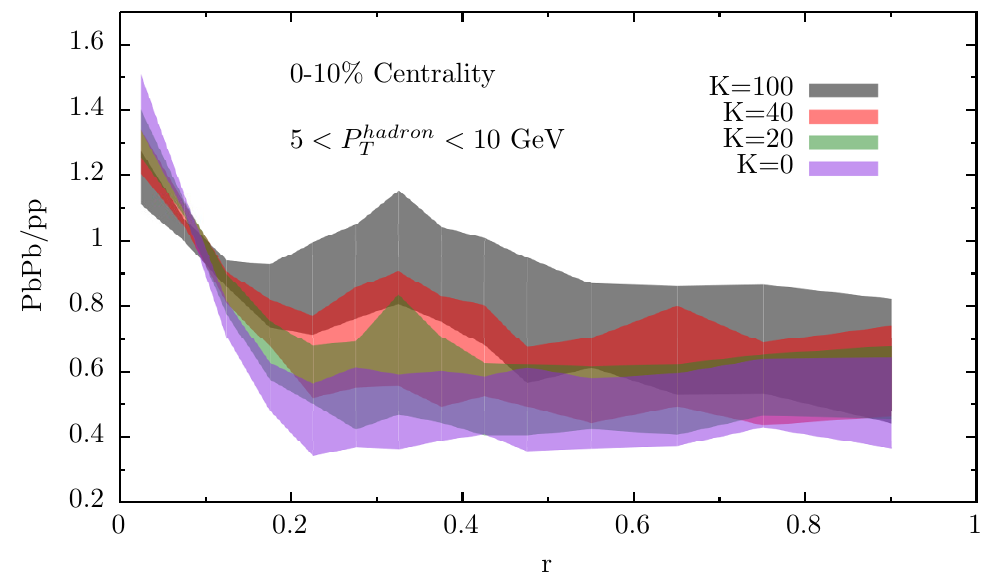
Figure 7 . Di(cid:11)erential jet shape ratio (cid:9) subleading ( r ) constructed from charged hadrons with 5 GeV < p T p T < 10 GeV, for subleading jets that satisfy the same cuts as in (cid:12)gure